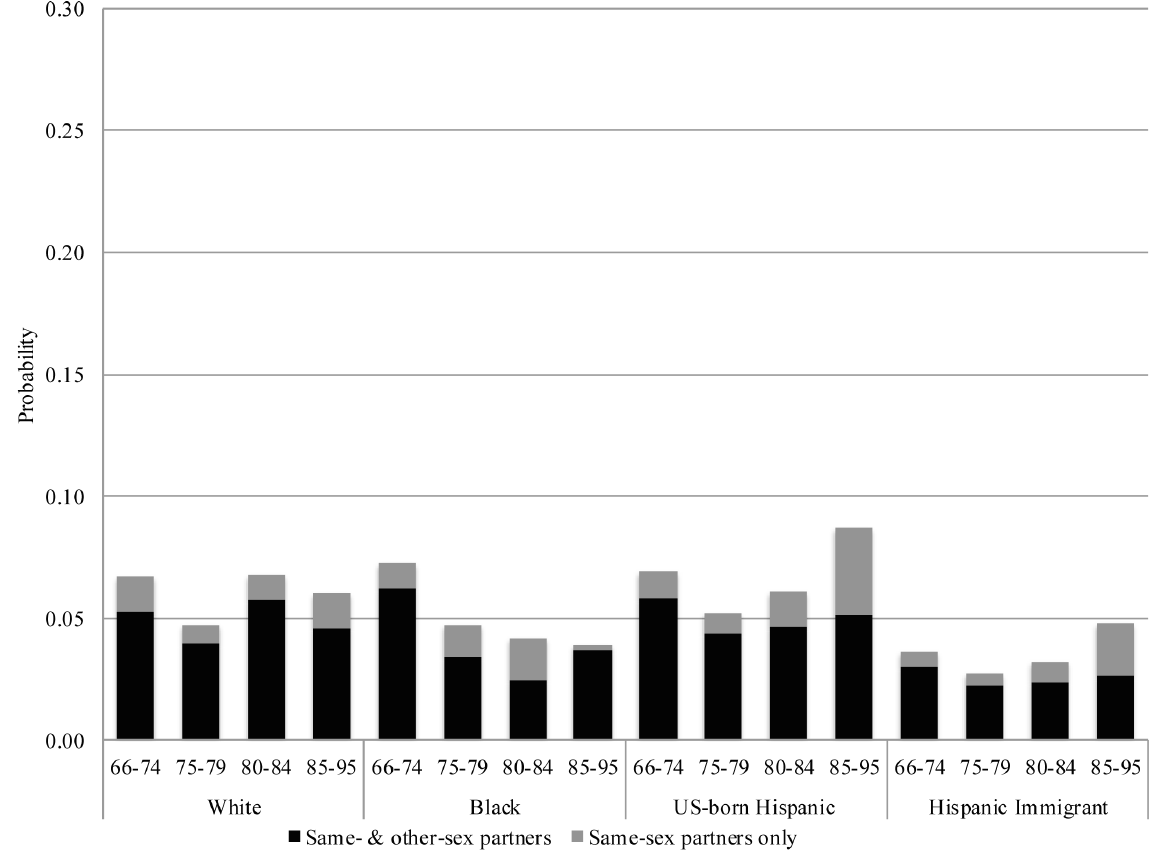
Figure 5: Men’s predicted probability of having had sex with same-and other-sex partners, by birth cohort and